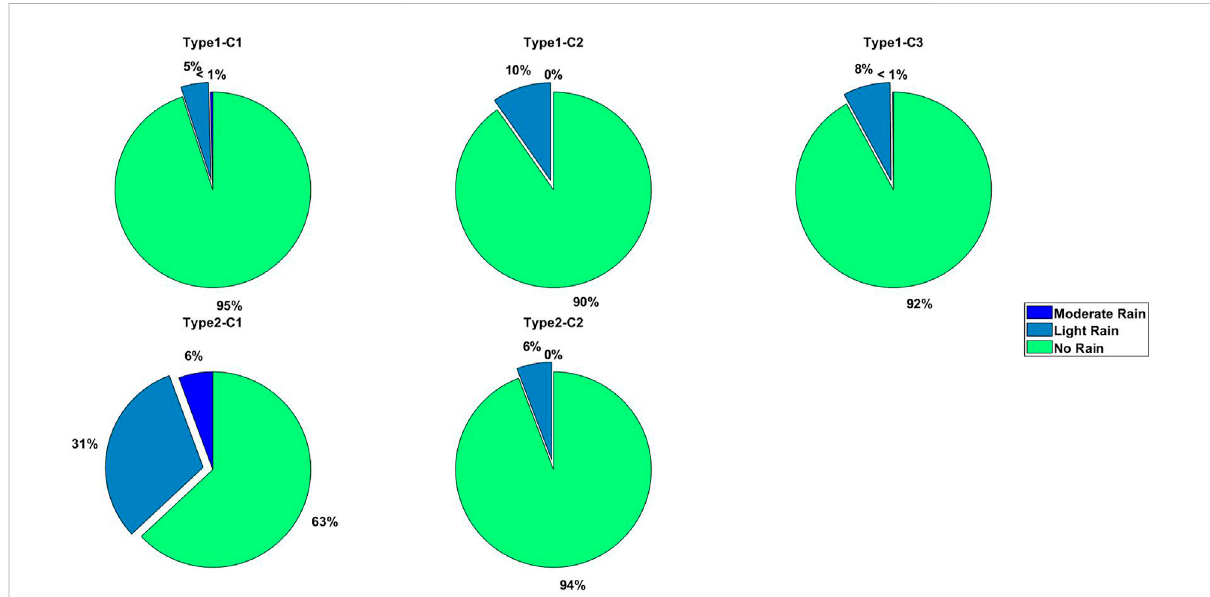
FIGURE 9 Precipitationintensitiesin5clustersofShanghaiseesawevents.Norain:therateoffallvaryingbetweenatraceand0.5 mmperhour.Lightrain: the rate of fall varying between 0.5 mm and 2.5 mm per hour. Mild rain: the rate of fall varying between 2.5 mm and 7.6 mm per hour (American Meteorological Society).